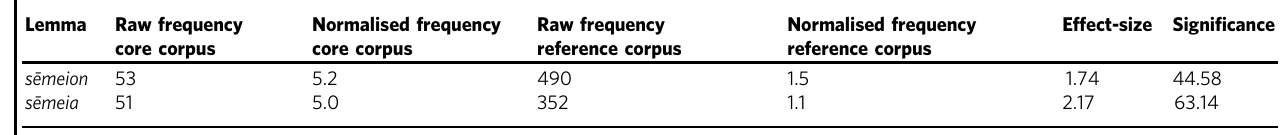
See Table 3 for keyness